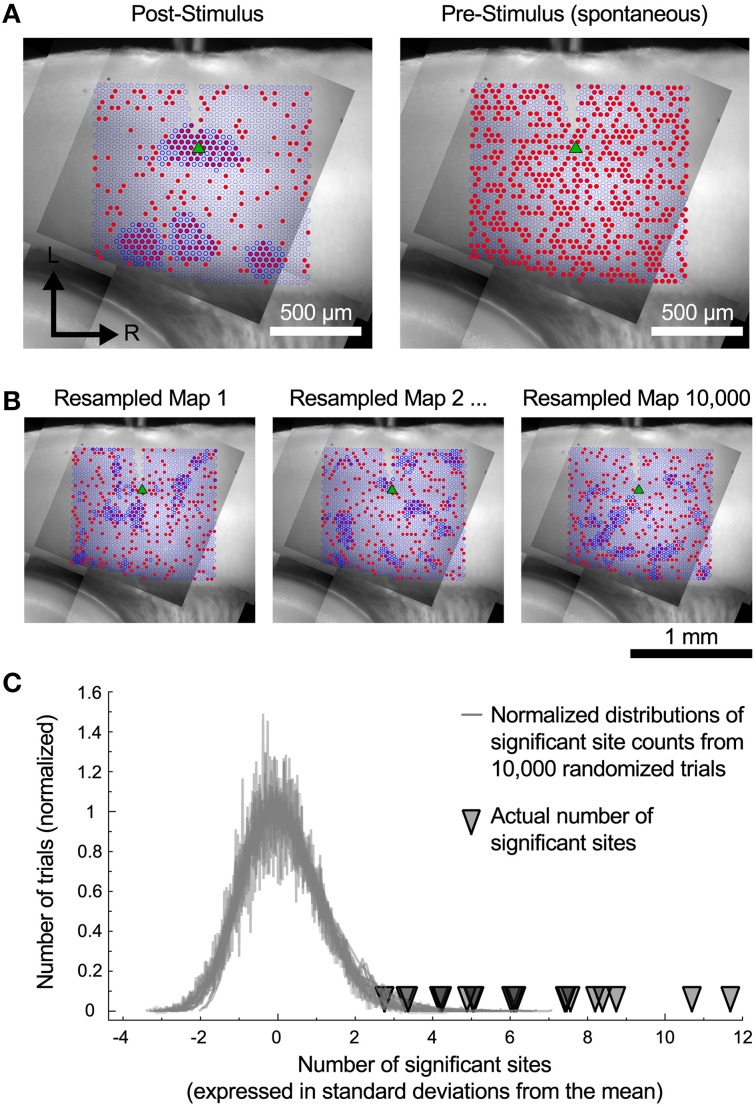
Resampled maps. (A) Maps of the spatial correlation of post-stimulus and pre-stimulus (spontaneous) events before random resampling. Red circles indicate sites with detected events. Dark blue outlines indicate sites detected by the spatial correlation algorithm. (B) Three examples of the same cell as in A with the event locations randomly shuffled. (C) The number of spatially correlated sites found in actual maps was always much higher than the distribution of such sites that would be detected if the spatial locations of individual inputs are shuffled.